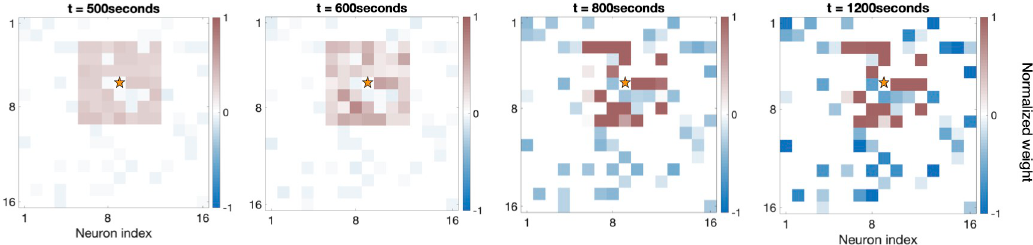
Fig 6. Evolution of the strength of the recurrent synapses onto one sample excitatory cortical cell shown at different time points during the second phase of development. The star indicates the location of the sample neuron. Inhibitory weights onto this cell are indicated by negative values and shown in blue while excitatory ones are positive and shown in red.